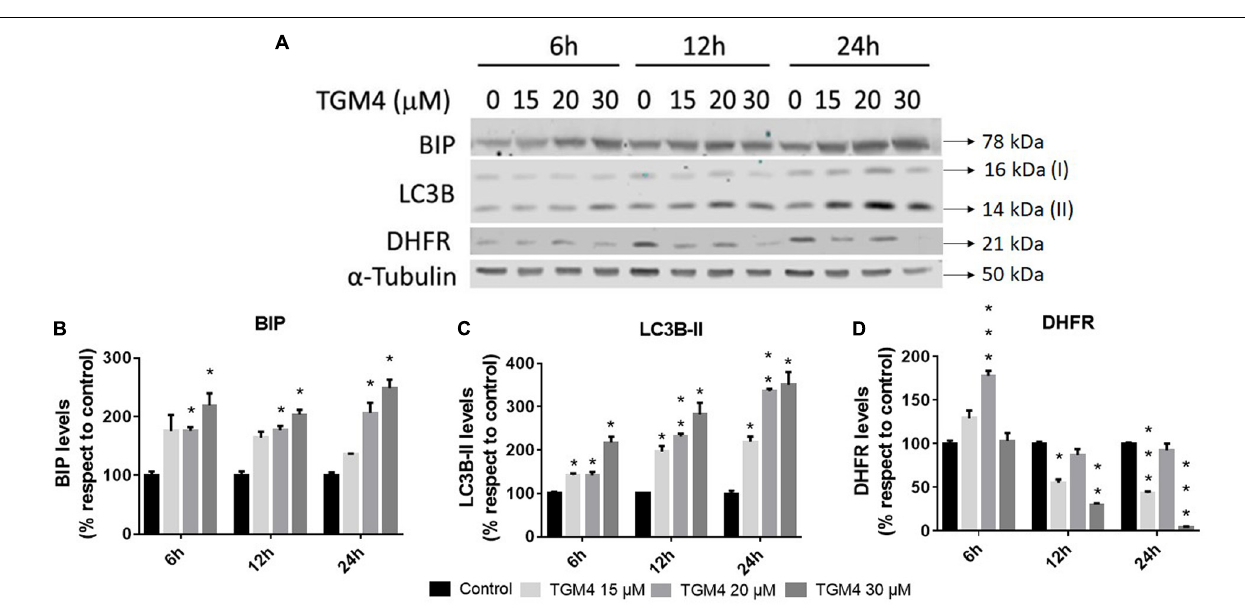
(Barone et al., 1994). PARP decreased after 12 h of treatment with 30 µ M TGM4 from 100 ± 2.44% in controls to 23.92 ± 0.70% ( p < 0.01), whereas CHOP was increased from 100 ± 8.70